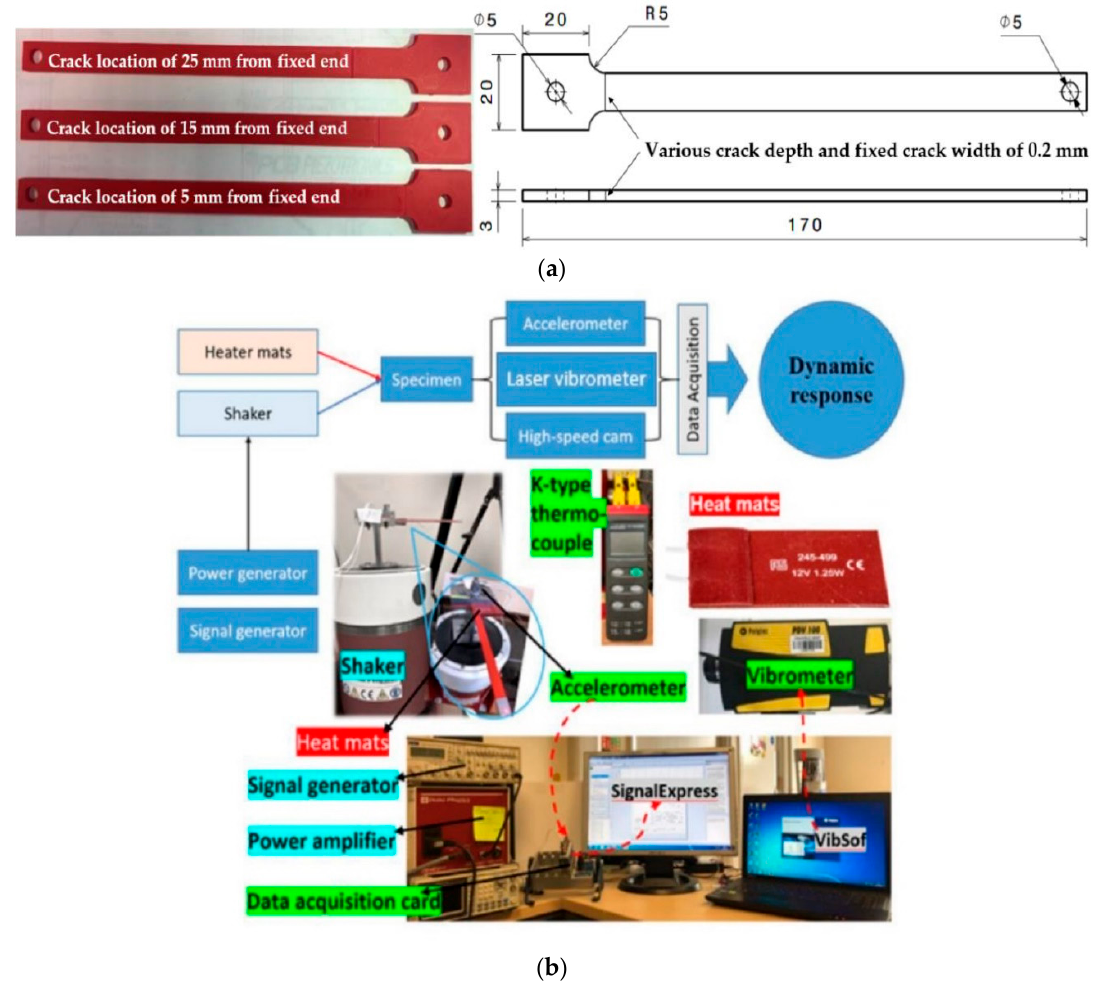
Figure 8. ( a ) Sample geometry, ( b ) the experimental setup.